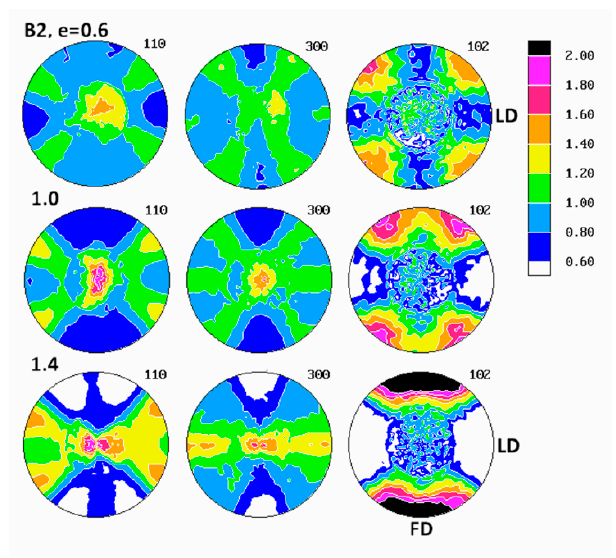
Figure 8. Selected normalized pole figures of the (110) (300) and (102) crystallographic planes (Form I) determined for samples of B2 homopolymer compressed in plane-strain to the true strain indicated.